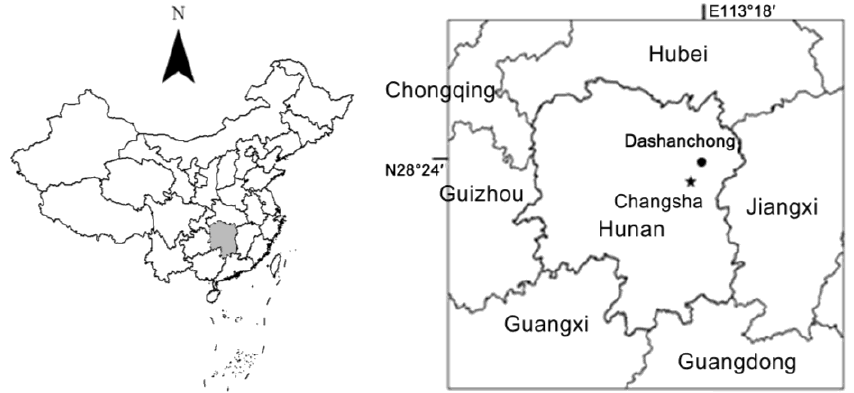
Figure 1. Location of the 1 ha permanent plot of subtropical broadleaved evergreen forest at Dashanchong Forest Farm, Changsha County, Hunan Province,